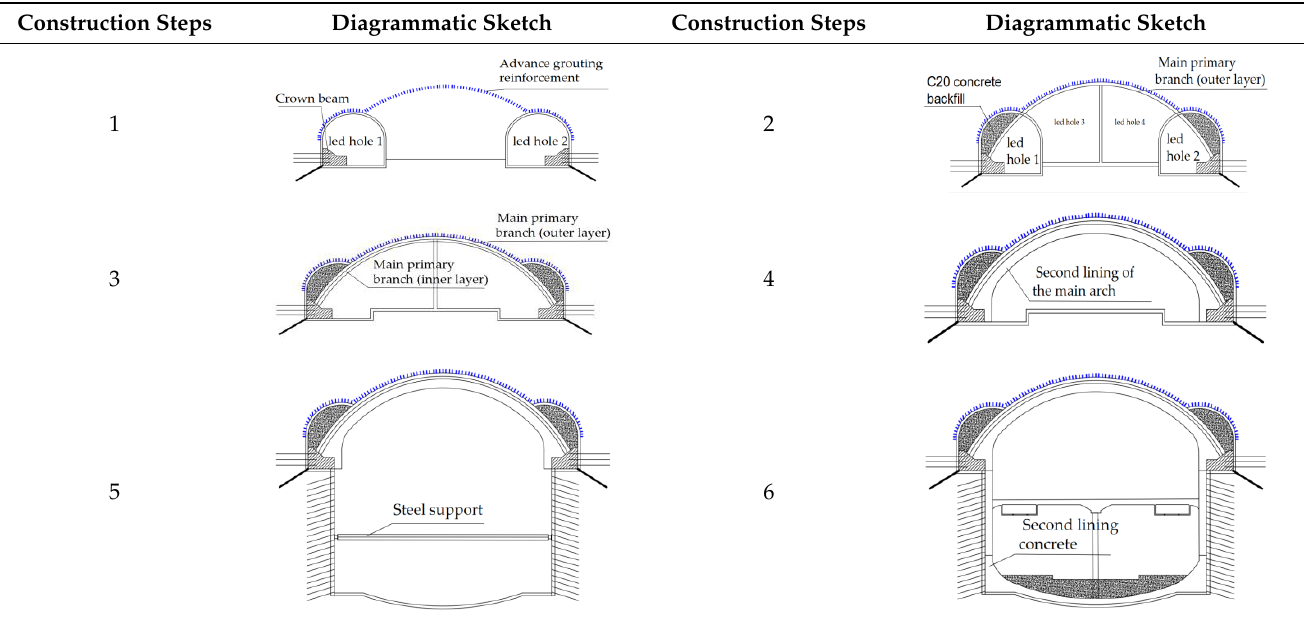
Table 2. Schematic diagram of arch cover method construction process.